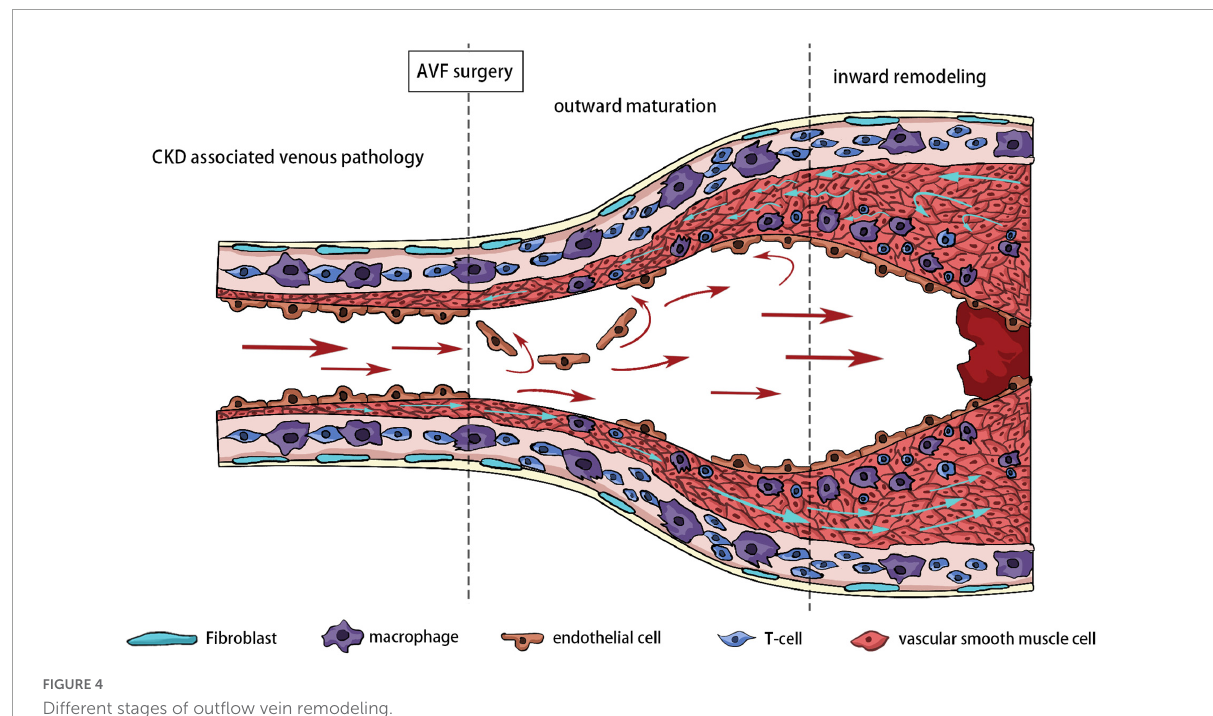
FIGURE4 Different stages of outflow vein